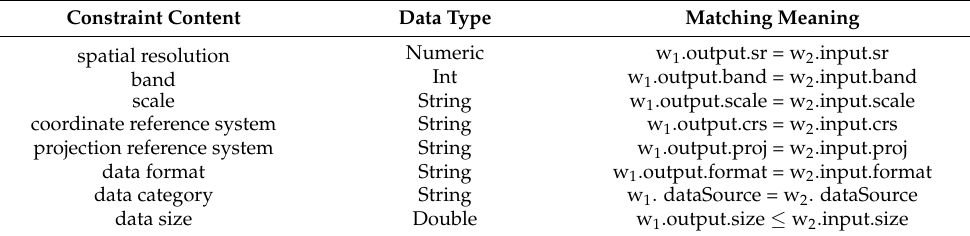
Table 1. Examples of service parameter constraints and their matching